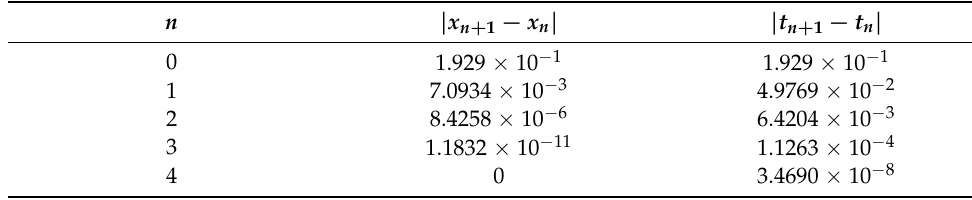
Table 4. Results for x 0 = 0.2 for Example